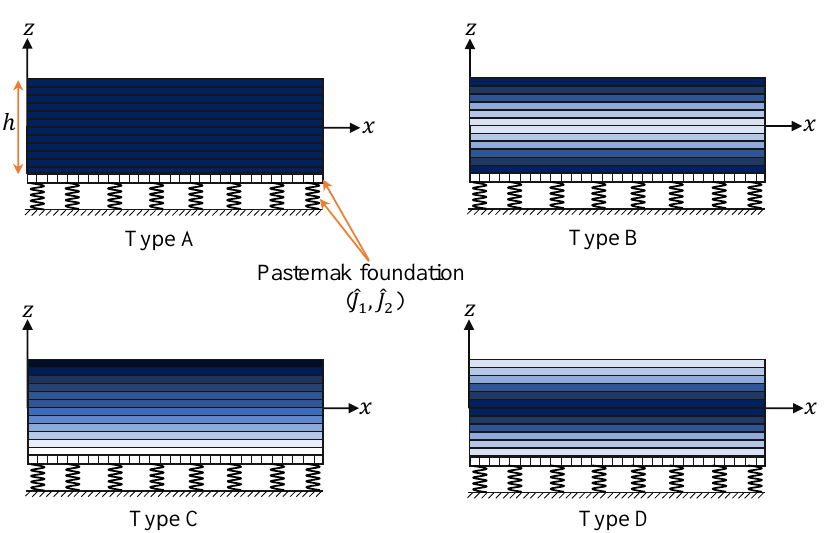
Figure 2. Various types of naocomposite piezoelectromagnetic